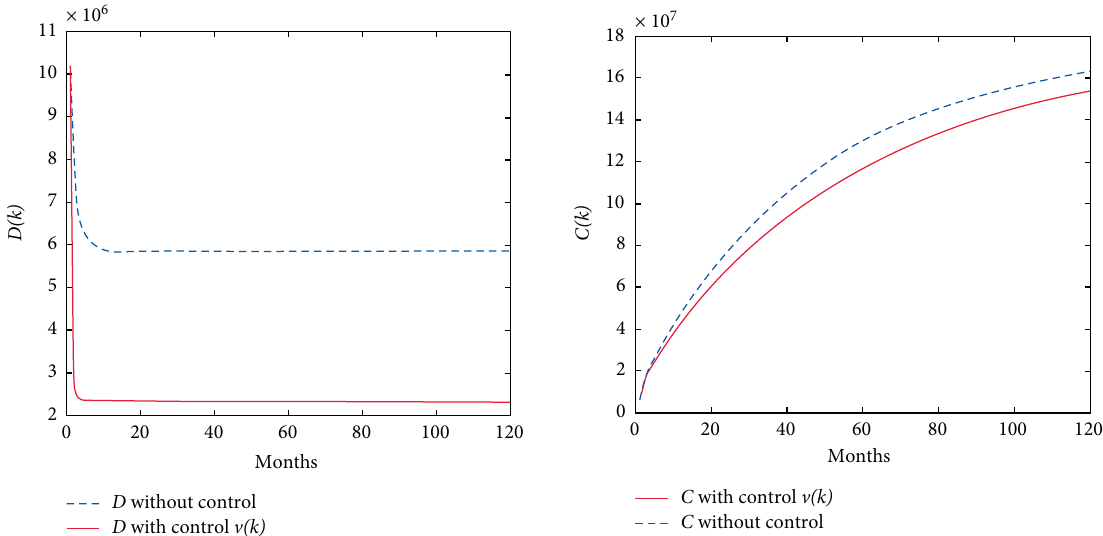
Figure 2: The evolution of the number of diabetics with and without complications with control v